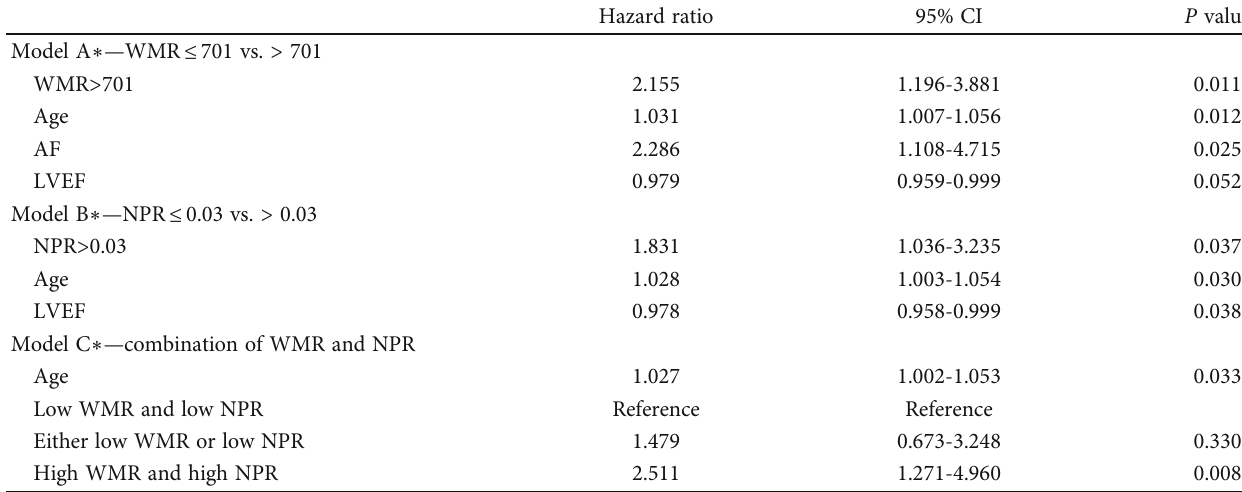
Table 3: Results of Cox proportional-hazards regression analysis.